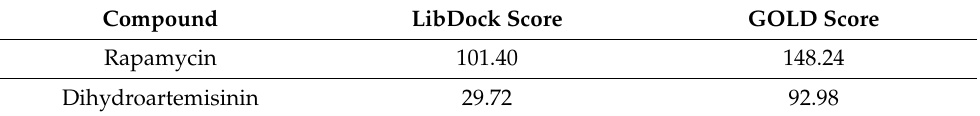
Table 1. Scoring function values of dihydroartemisinin and rapamycin in molecular docking studies, in which the agents were docked into the active pocket of FKBP12 (PDB ID: 3FAP).